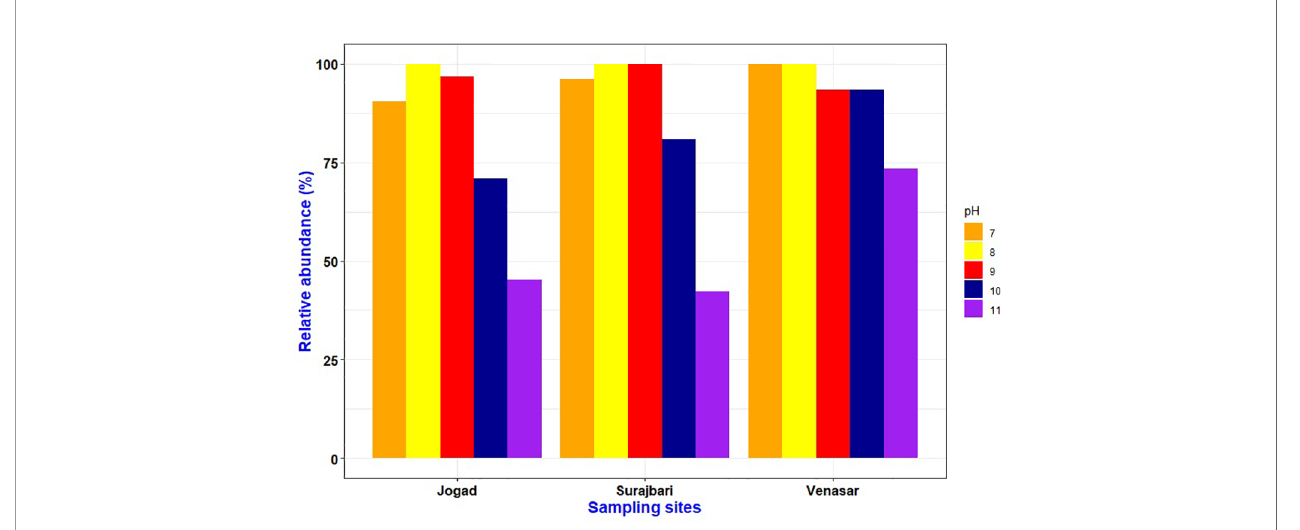
FIGURE 3 | Comparative pro fi le showing effect of pH on growth of isolates from Surajbari, Venasar, and Jogad study